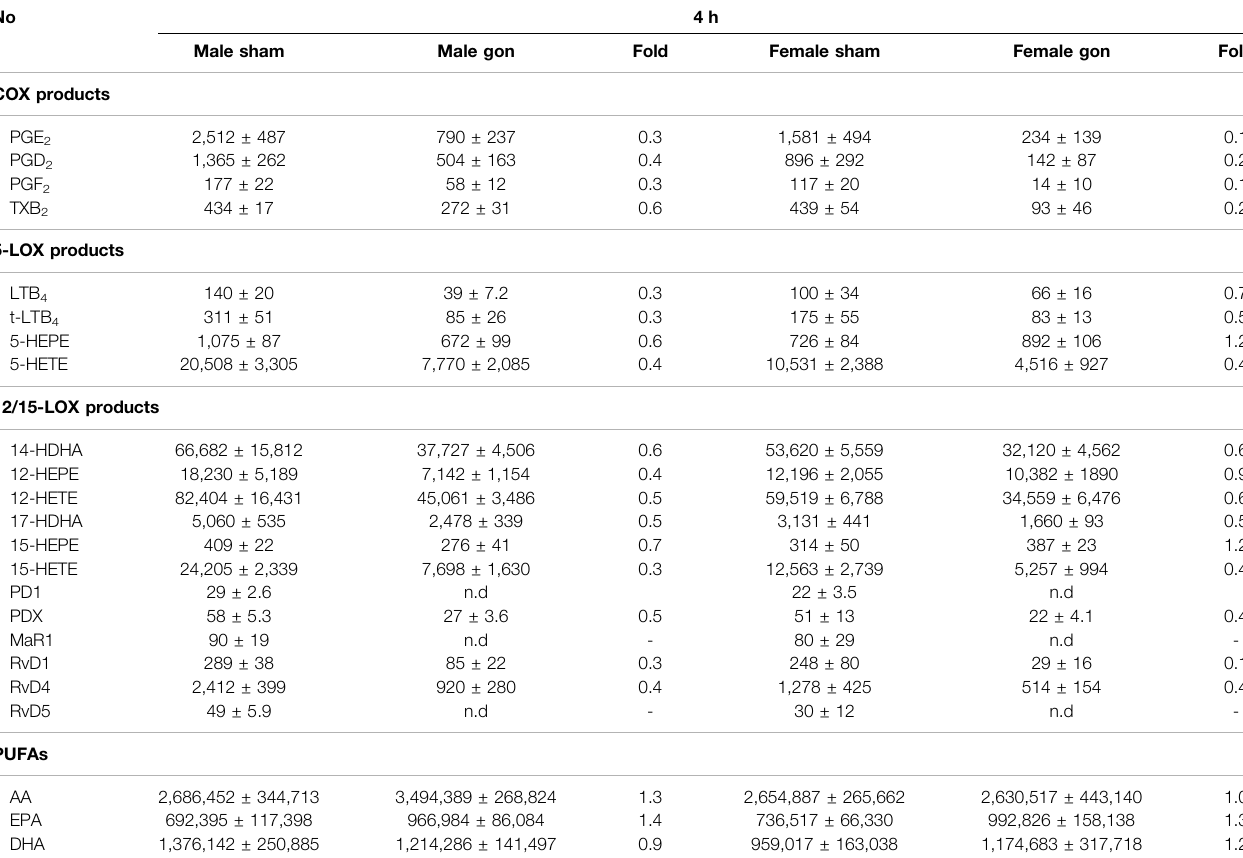
TABLE4| Effectofhormonedepletiononlipidmediatorpro fi lesinplasmafrommaleandfemalemiceat4 hpost-zymosaninjection.AmountsofLMinplasmafrommaleand female mice 4 h post zymosan/vehicle i.p. injection that underwent gonadectomy or sham-operation. Dataofn (cid:1) 5 to 6 animals per group are shown as mean ± SEM in pg/mL plasma and as heatmap. Fold-change of gonadectomy mean values compared to sham mean values of male and female